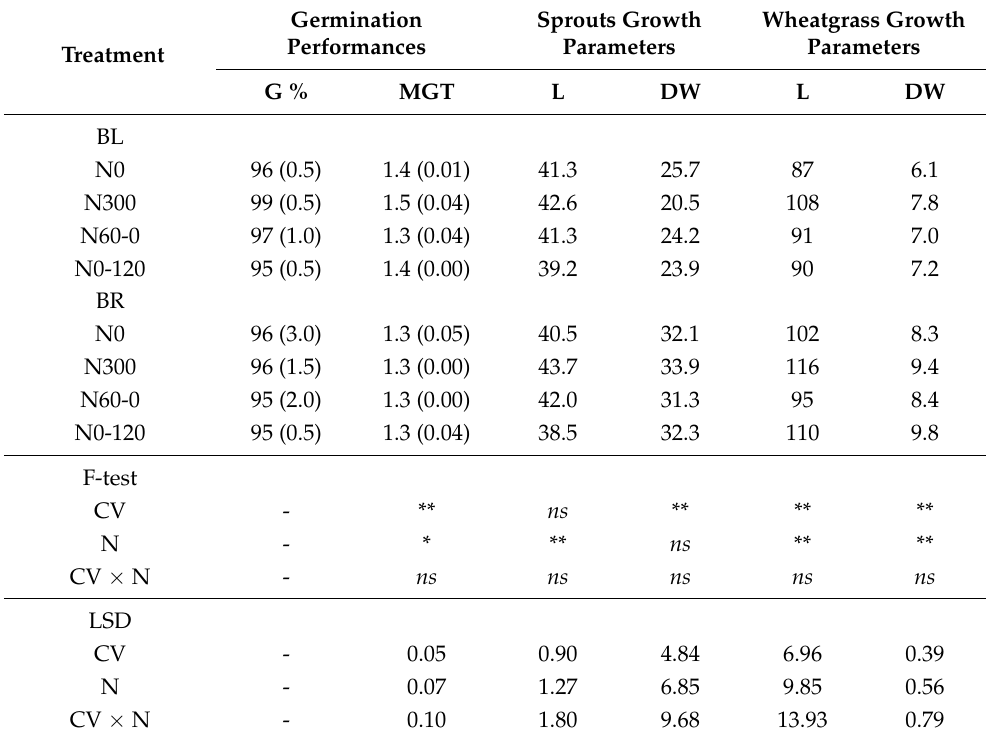
Table 1. Total germination % (G), mean germination time (MGT, expressed as days after sowing— DAS), and individual sprout and wheatgrass parameters: lengths (L, mm) and dry weights (DW, mg). Sprouts and wheatgrass were obtained from seeds of two Triticum aestivum cultivars (Bologna, BL; Bora, BR) subjected to four different N fertilization schedules (N0: unfertilized control; N300: constantly well N fertilized throughout the growth cycle; N60-0: N fertilized only one